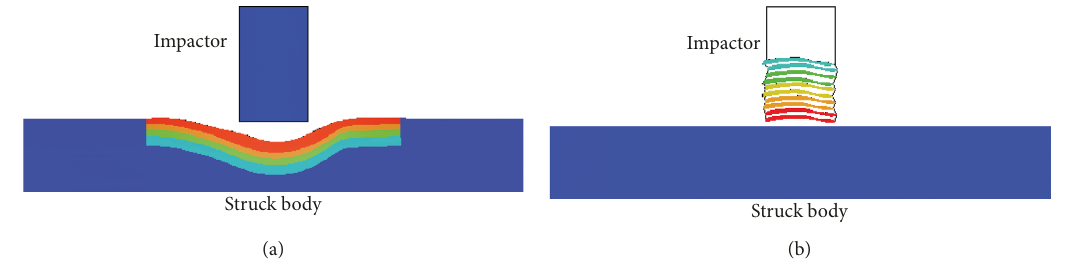
Figure 3: Impact types: (a) soft impact and (b) hard impact.